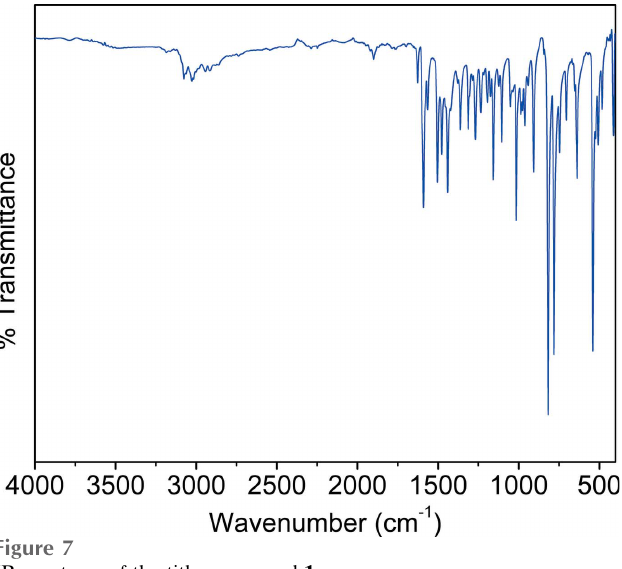
Figure 7 IR spectrum of the title compound 1